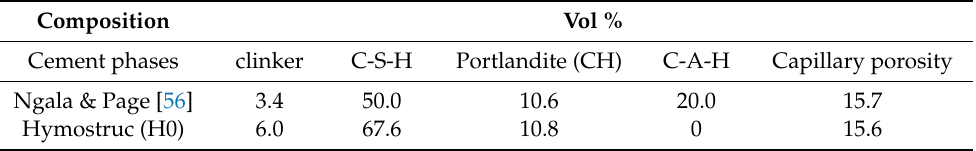
Table 1. Volume fractions of cement